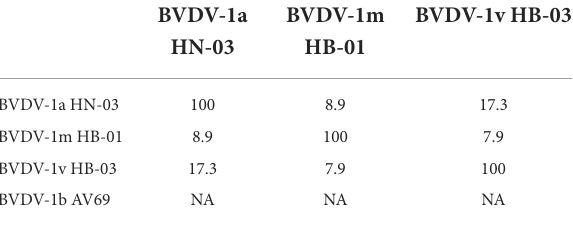
TABLE 5 Serological relatedness expressed as coefficient of antigenic similarity ( R ) values of BVDV-1 genotypes.